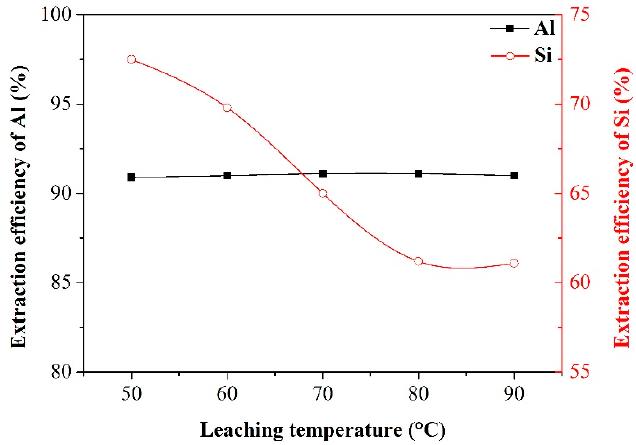
Figure 8. E ff ect of leaching temperature on the extraction e ffi ciency of Al and Si. Figure 8. Effect of leaching temperature on the extraction efficiency of Al and Si.